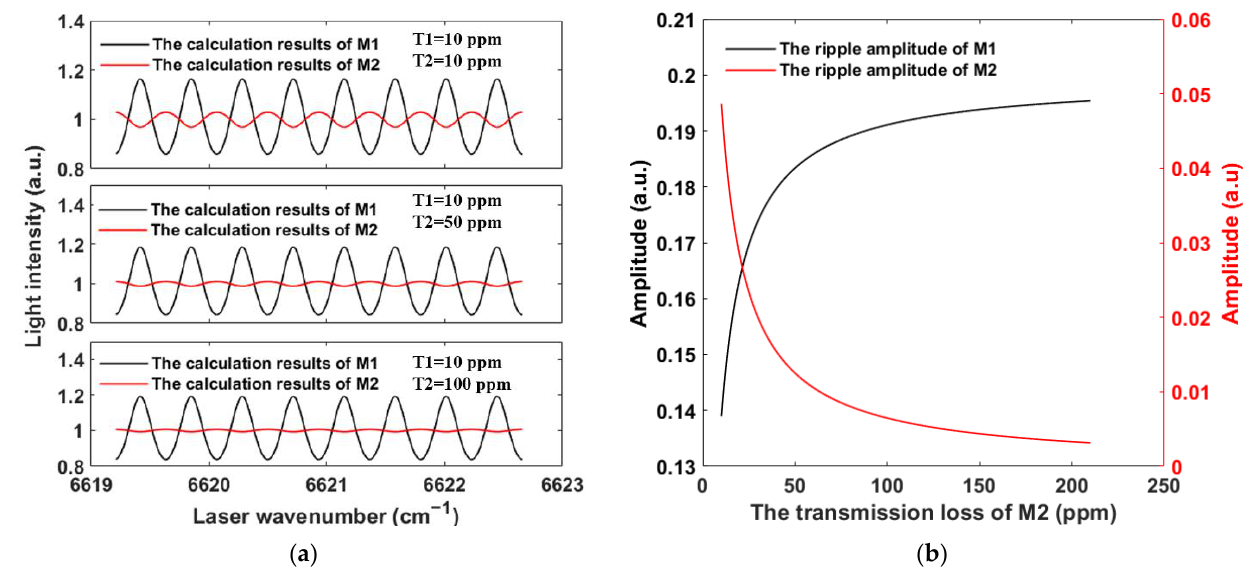
Figure 4. ( a ) Simulated transmitted light intensity of M1 and M2 with different transmission loss; ( b ) Ripple amplitude variation curve with transmission loss of M2.